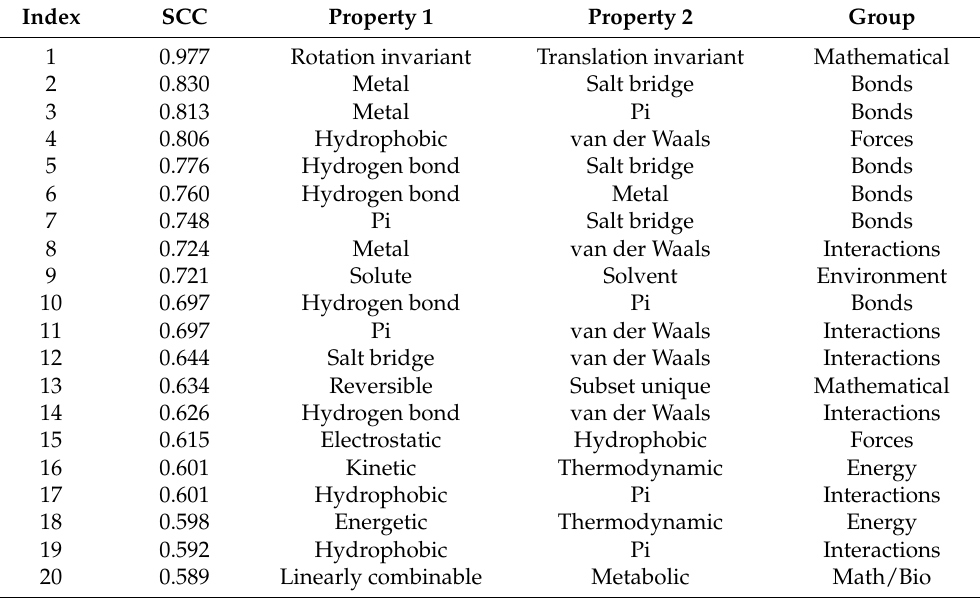
Table 2. Feature property correlation and assigned groups. Spearman correlation coefficients (SCC) are used to rank the top twenty pairs in the feature